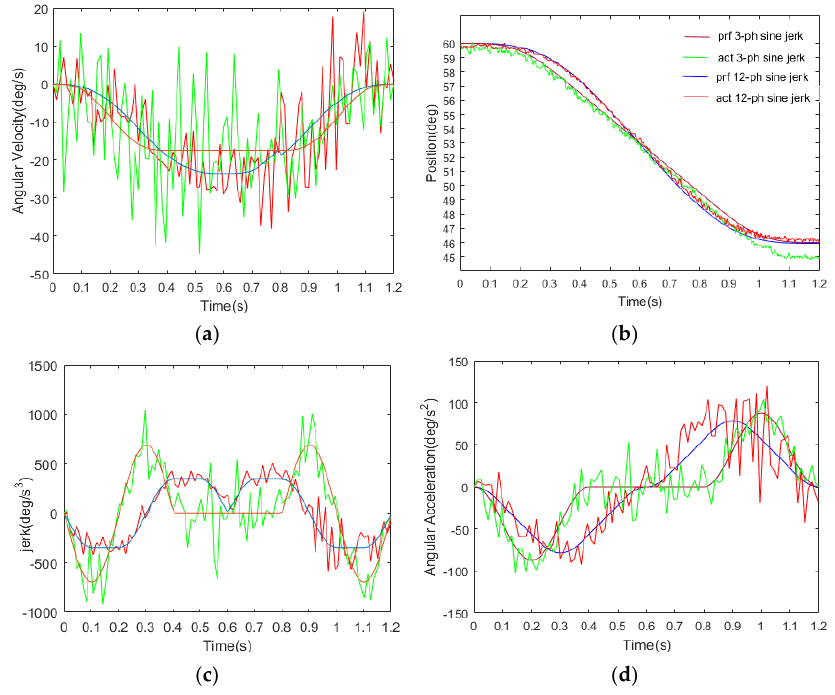
Figure 6. Simulation and experimental comparison curves of key characteristic in Joint 1: ( a ) angular displacement curve, ( b ) angular velocity curve, ( c ) angular acceleration curve, and ( d ) angular acceleration rate.